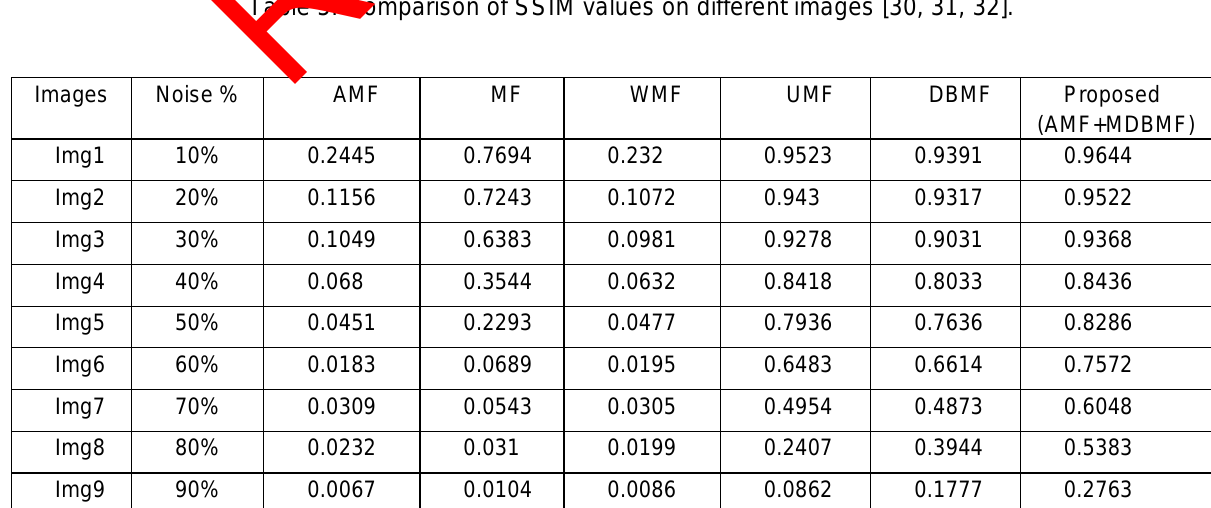
Figure 7. Comparison of IEF values on different images Table 5. Comparison of SSIM values on different images [30, 31,